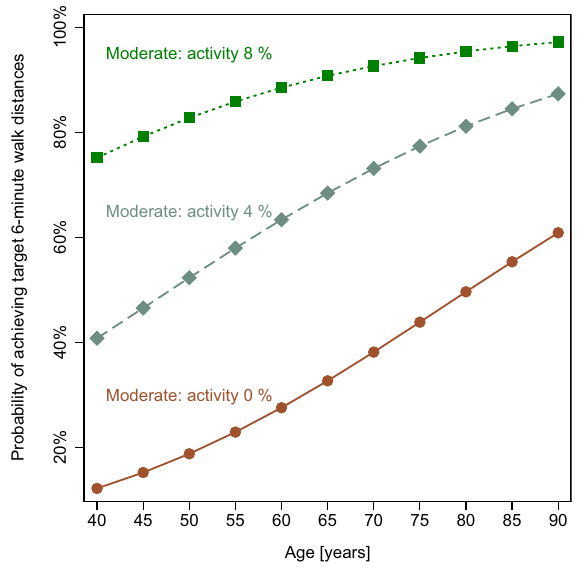
Fig. 4 Probabilities of achieving target 6-minute walk distances dependent on age. Curves represent different percentages (0, 4 and 8%) of daily time spent in moderate